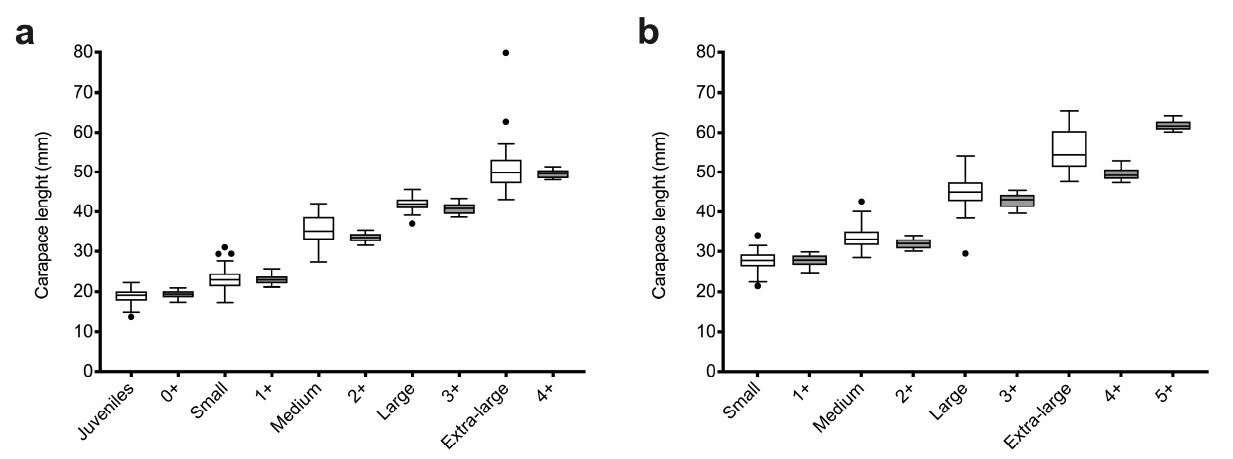
Figure 4. Carapace length (CL) of A. antennatus female groups based on commercial categories (white boxes) and the modal progression analysis components (MPA, grey boxes) in winter ( a ) and summer ( b ). The line that cuts through the box indicates the median value.